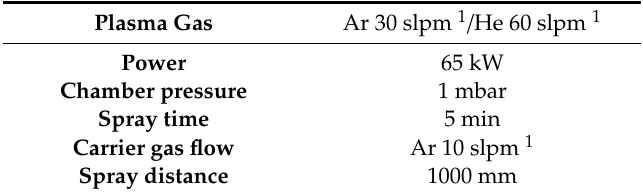
Table 2. Processing parameters for La 2 Ce 2 O 7 (LC) coatings by plasma spray-physical vapor deposition